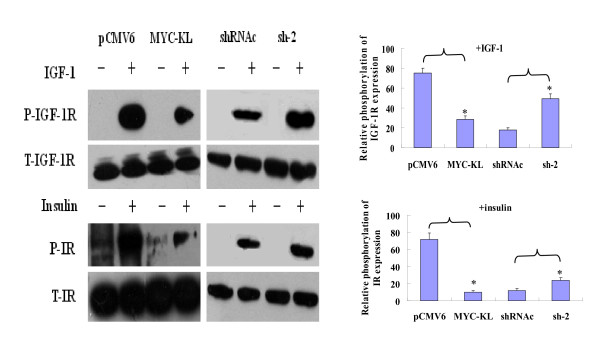
Downregulation of the IGF-1/insulin pathways by klotho in lung cancer cell line A549. A549 cells were transfected with either MYC-KL or control vector pCMV6. After 24 hr, cells were serum-starved for 24 hr and treated with IGF-1 (10 min, 25 nM) or insulin (10 min, 100 nM). Following treatment, cells were harvested and proteins were resolved and immunoblotted using antibodies either directed against phospho (P) and total (T) IGF-1R or phospho (P) and total (T) insulin-R (IR). Similar treatment was done when silenced the klotho of the cells using sh-2 or control shRNAc. Data shown are the mean results ± SD of a representative experiment performed in triplicate (n = 3), *indicates p < 0.01.